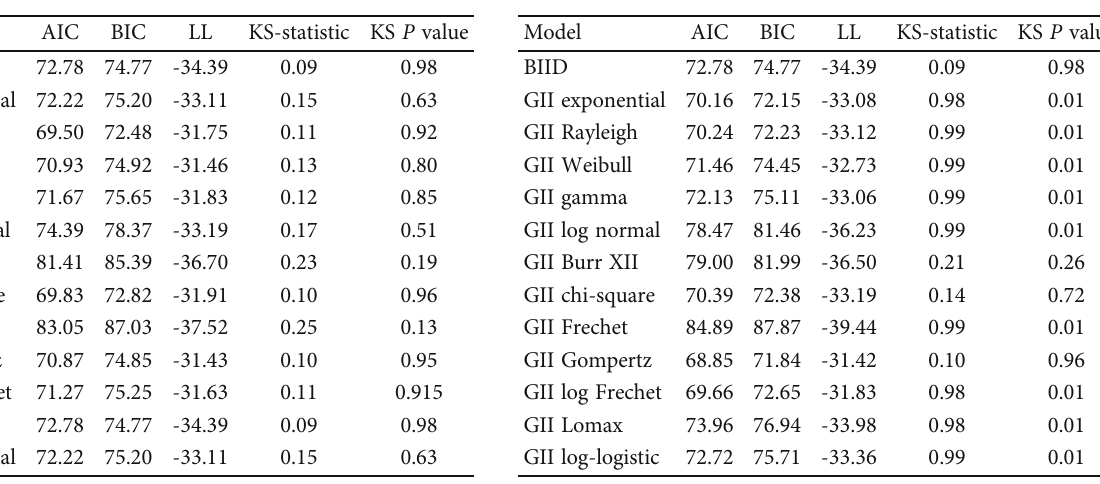
Table 17: Comparison of BIID with class of GGIIDs using real dataset-1.